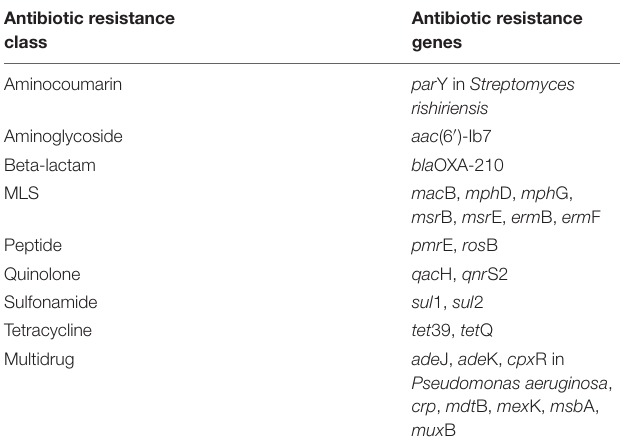
TABLE 1 | Top 25 most abundant core influent ARGs (detected in all sampling events), based on mean relative abundance, that were also detected in secondary effluent core resistome determined by